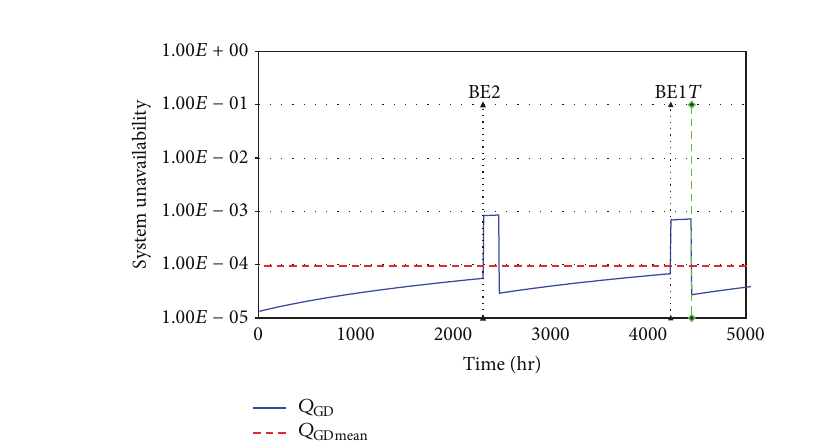
with black dashed lines on Figure